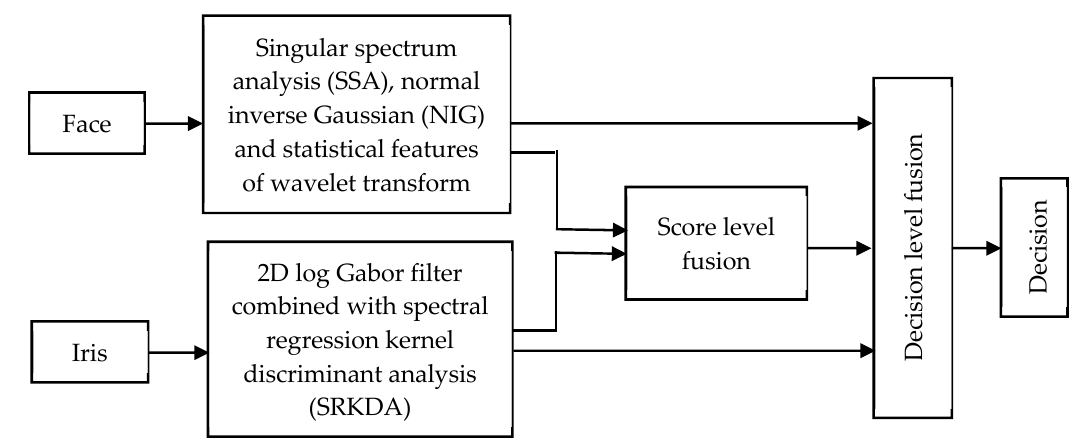
Figure 11. Scheme of the proposed face-iris multimodal biometric system.